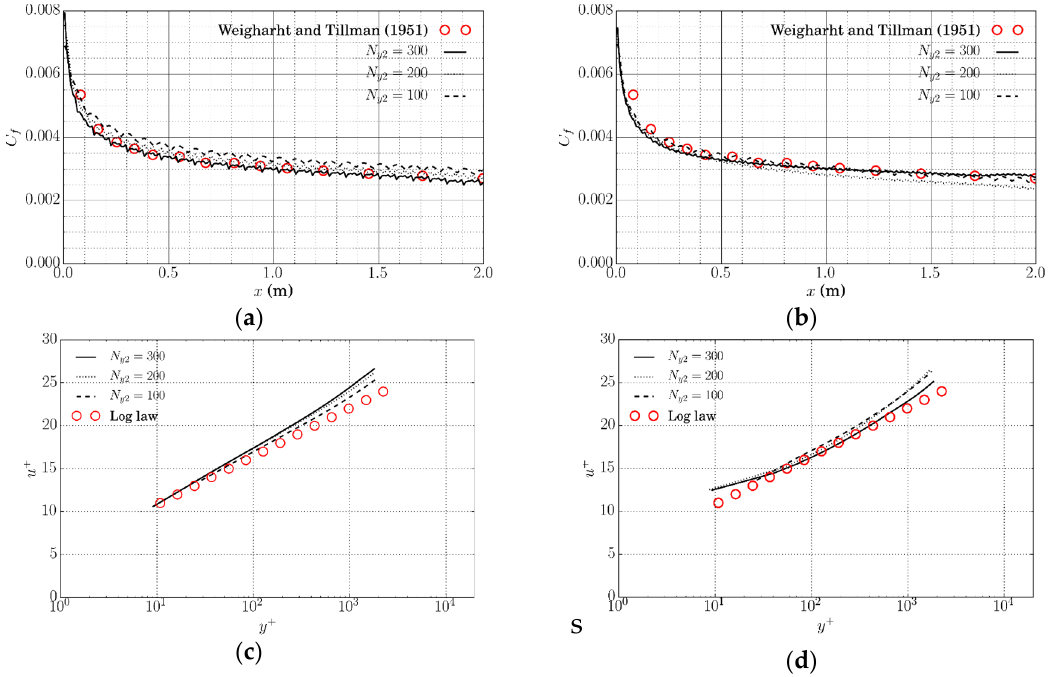
(cid:2025)(cid:1847) (cid:2870) (cid:3415) ) and velocity profile at ρ U 2 ) and velocity profile (cid:2870) 2